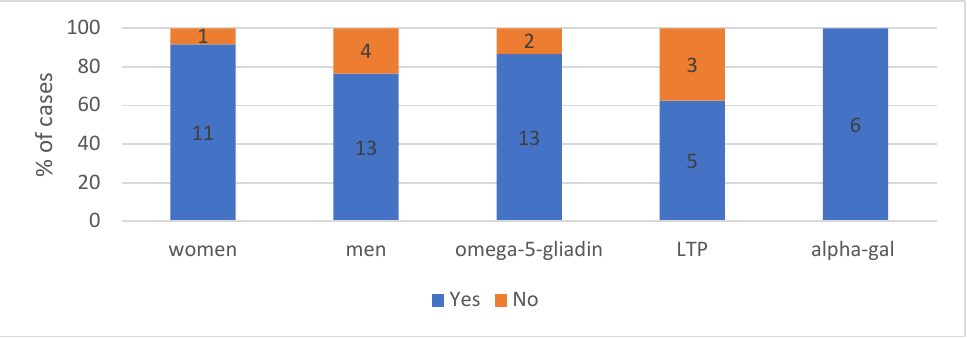
Figure 10. The provision of an emergency kit to patients for self-administration in the study group with division into individual causes and gender. Absolute values of numbers of patients are given in the diagram.